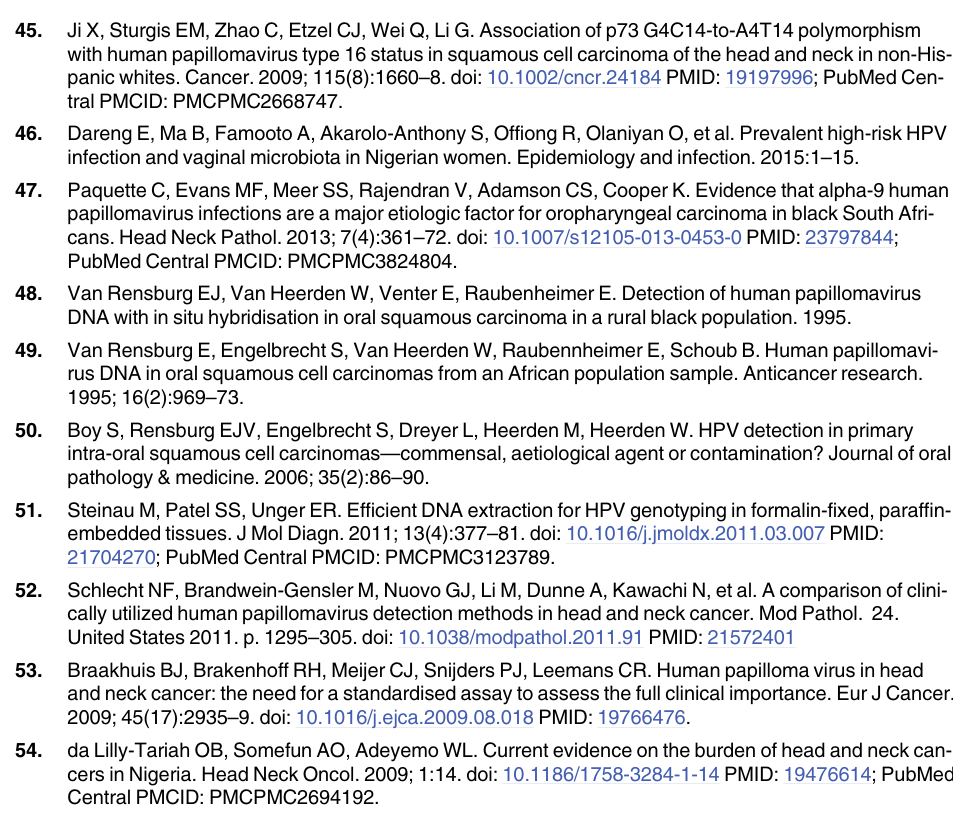
PLOS ONE | DOI:10.1371/journal.pone.0152828 April 6,